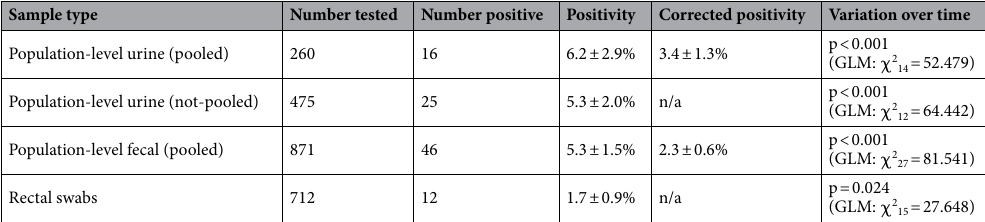
Table 2. Overall detection rates of henipavirus and related viral RNA in different sample types across the sampling